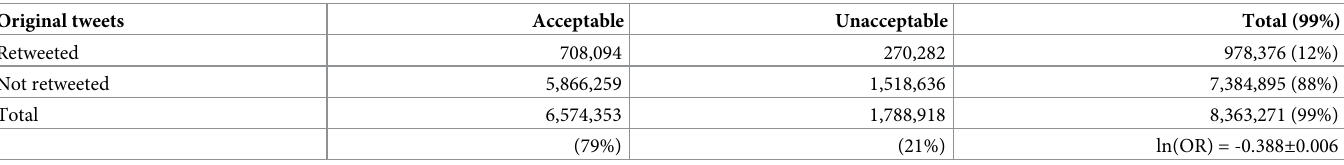
Table 2. Proportions of the (un)acceptable and (not) retweeted tweets over the three year period. The odds ratio (OR) statistic confirms that acceptable tweets are retweeted significantly less often than the unacceptable tweets. Original